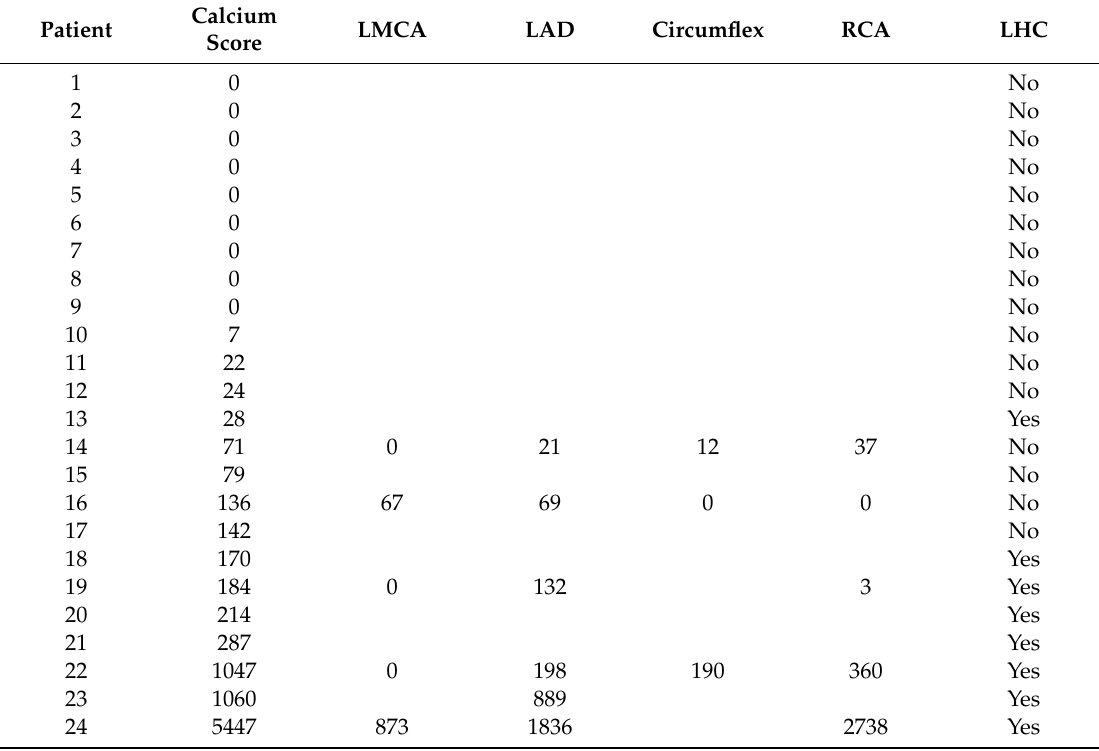
Table 4. Calcium scores and location (if available) for patients who underwent coronary artery assessment (CAA) with CT prior to pancreas